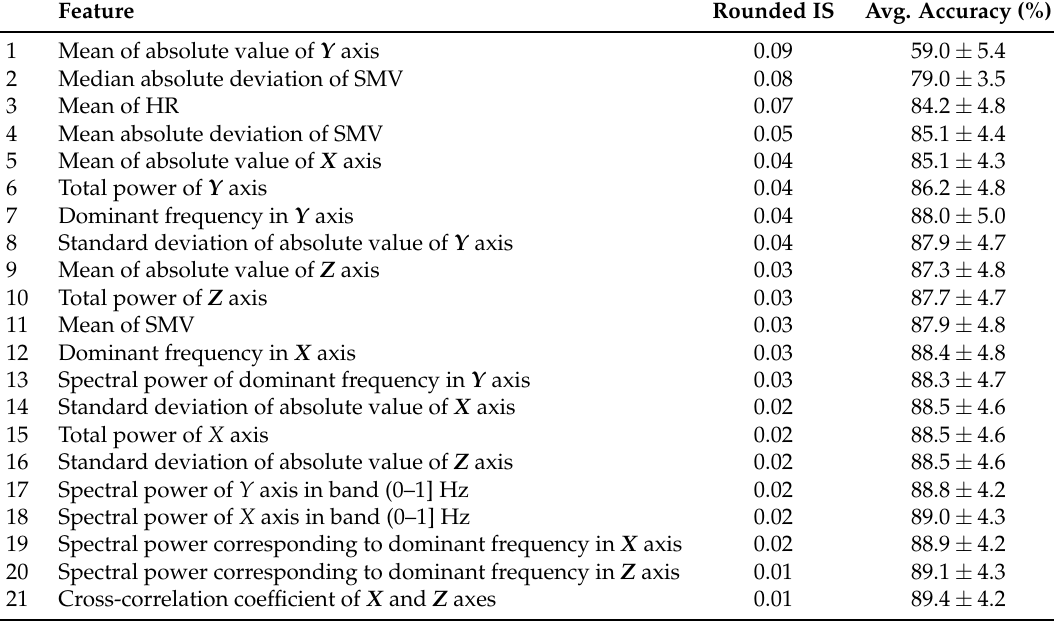
Table 2. The 21 most important features along with their corresponding importance scores (IS), as well as the average percentage of classification accuracies (Avg. Accuracy) expressed as the mean ± standard deviation. By moving from top rows to the bottom, the feature set was grown by one feature at a